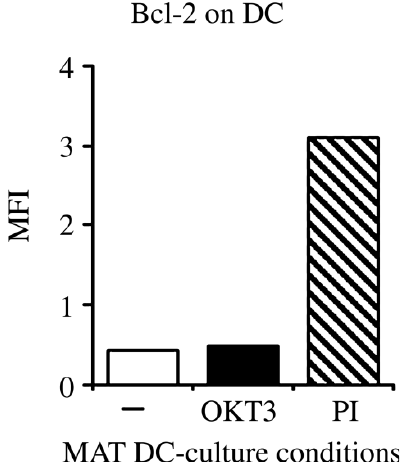
FIGURE 6 Anergic cells do not favor up-regulation of Bcl-2 in DC. 2 £ 10 4 “mature” DRB1*1101 þ DC, pulsed with HA307-19, were cultured either alone ( 2 ) or with anergic (OKT3) or activated (PI) F17. The cells were co-cultured at 37 8 C for 48h and Bcl-2 expression on DC was assessed by FACS after intracellular staining. Data shown, expressed as mean of fluorescence intensity (MFI), are from one of two separate